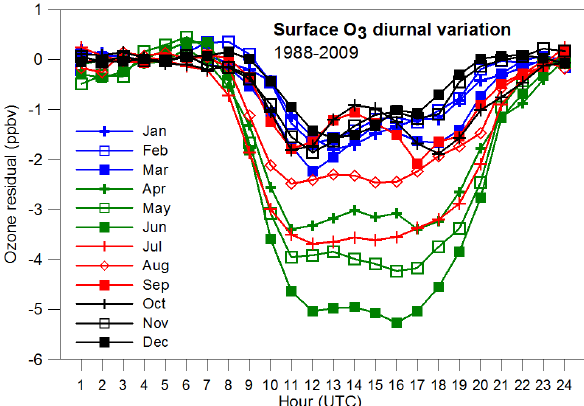
Fig. 1. Diurnal variation of surface O 3 residuals for each month of the year in the period 1988–2009. The O 3 residuals have been calculated on a daily basis as the differences of surface O 3 for every hour compared with the night background level.